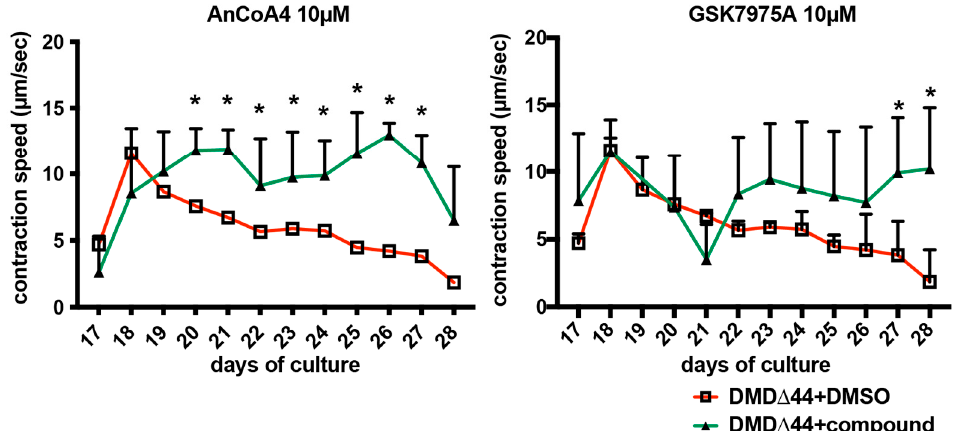
Figure 4. Amelioration of the declines in contractile performance upon administration of Orai1/STIM1 inhibitors in the long-term training model. Quantitative time-course analyses of the contraction velocity upon administration of Orai1/STIM1 inhibitors using DMD ∆ 44-ctrl and DMD ∆ 44. Data represent the mean ± standard deviation (SD) and were analyzed using an unpaired t -test from at least three biological replicates. * indicates p <